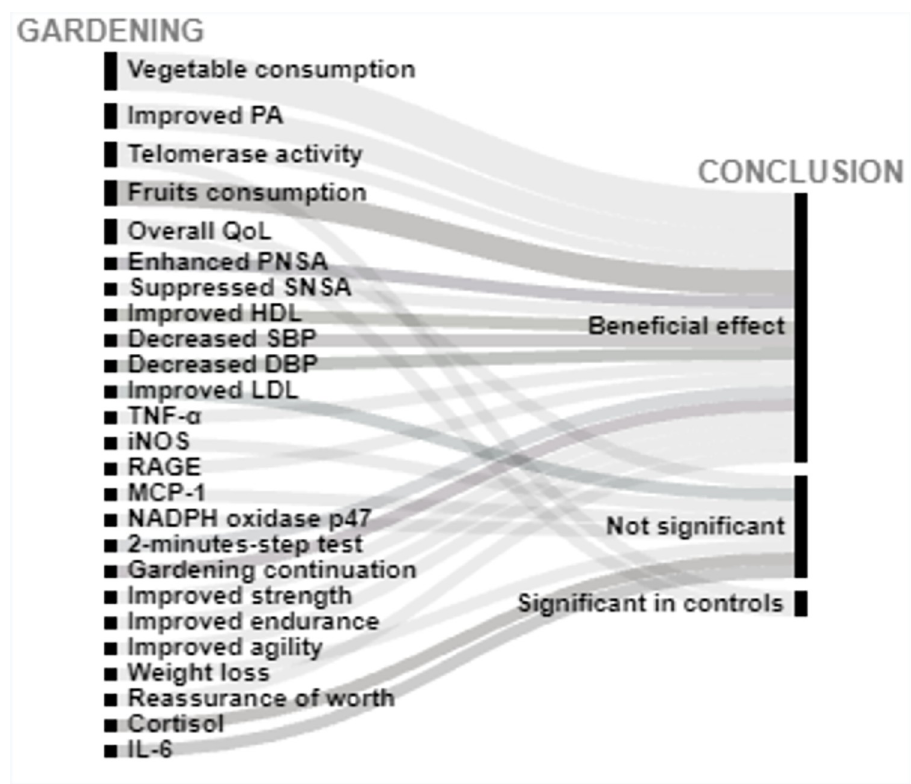
Fig 6. Vegetable gardening intervention effects on outcomes related to CV health and cancer: Trends of associations among all statistical tests conducted. The first column represents outcome measures while the second column represents summary conclusions in terms of protective effects (beneficial effect), no significant results (not significant) or control groups had better outcomes than experimental groups (significant in controls). Acronyms : PA 1 : Physical activity; QoL 2 : Quality of life; PNSA 3 : Parasympathetic Nervous System Activity; SNSA 4 : Sympathetic Nervous System Activity; SBP 5 : Systolic blood pressure; DBP 6 : Diastolic blood pressure; HDL 7 : High-density lipoprotein; LDL 8: Low-density lipoprotein; TNF- α 9 : Tumor necrosis factor alpha; RAGE 10 : Receptor for advanced glycation end products; iNOS 11 : Inducible nitric oxide synthase; MCP-1 12 : Monocyte chemoattractant protein-1, and IL-6 13 :